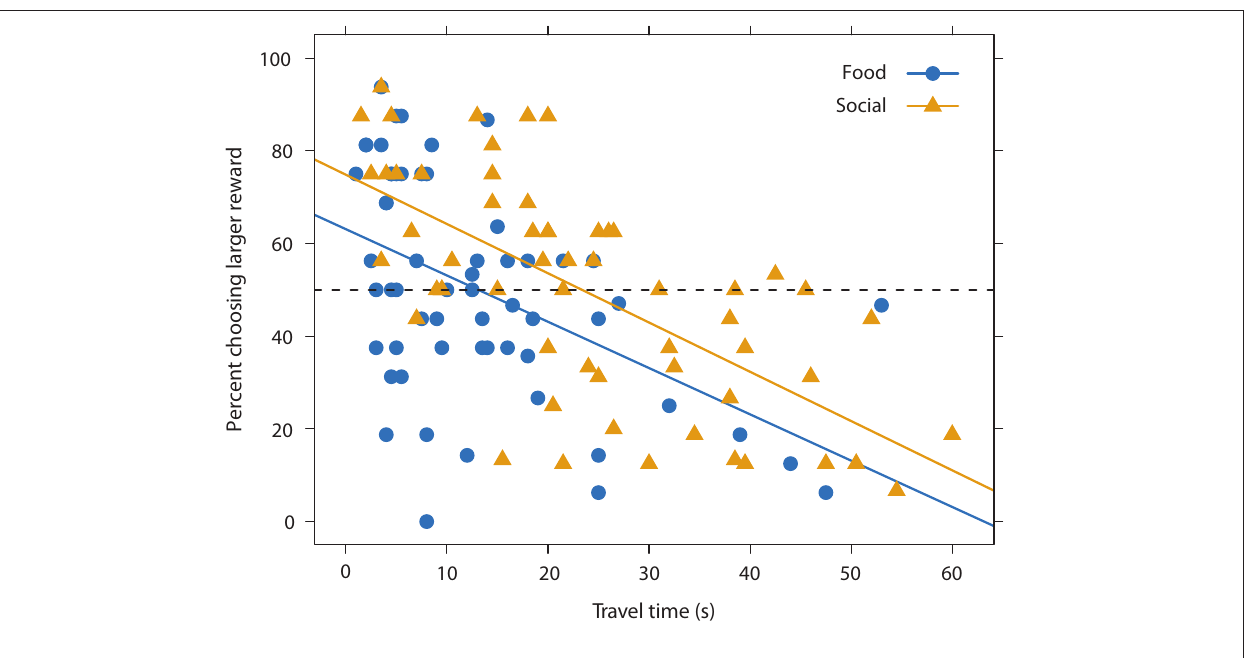
Figure 6 | Preference for larger option as a function of travel time and reward type. Data points represents the mean travel time and mean preferences for smaller versus larger option for each subject, distance, and reward type. Because each subject is represented multiple times, the data